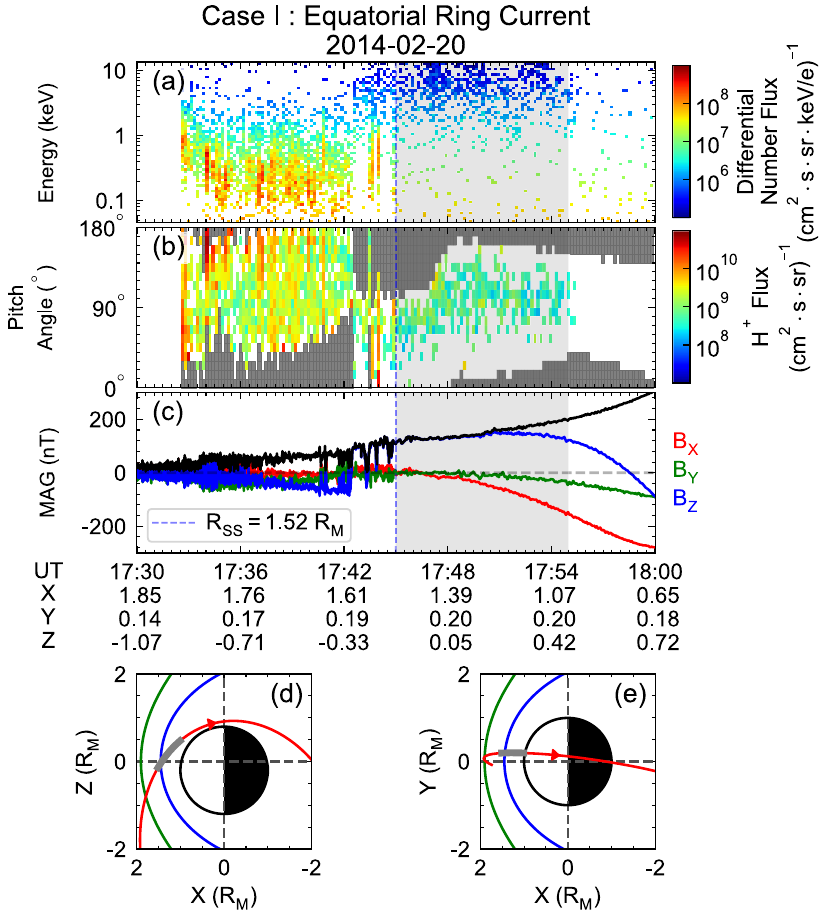
Fig. 1 MESSENGER observations during dayside magnetosphere crossing with potential equatorial ring current on Feb 20 th , 2014. a Energy spectrum of the protons. b Corresponding pitch angle distribution, with uncovered pitch angle bins noted by grey grids. c Components of the magnetic fi eld (red, green, and blue solid lines represent the B x ; B y and B z components, respectively) and strength (solid black line). d , e the trajectory of MESSENGER in XZ, XY planes. The thick shaded areas in a – c indicate the time periods during which FIPS observed trapped energetic protons. The corresponding spacecraft locations during these intervals are plotted in d and e as bold grey lines, and the green and blue curves show the modelled dayside bow shock and magnetopause that is obtained from the statistical distribution of observed crossing points 12 , respectively. The white and black half-circles represent the dayside and nightside hemisphere of Mercury, respectively. See Supplementary Fig. 7 for the colour alternative version of this fi